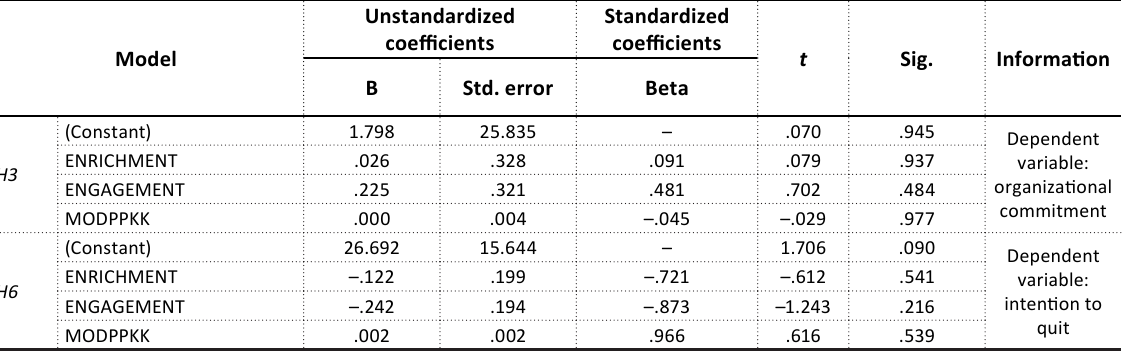
Table 4. Hypotheses test results with interaction